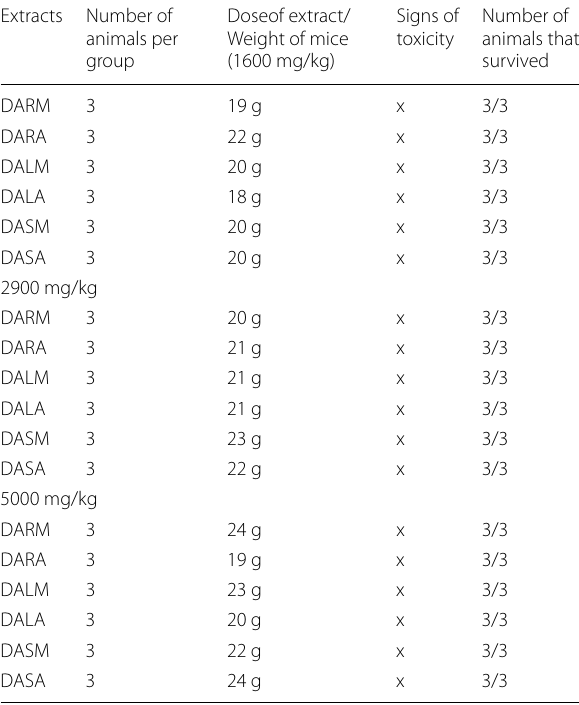
Table 3 Acute toxicity test (LD methanolic extracts of the roots, leaves, and stem of Dictyandra arborescens at high doses of 1600, 2900 and 5000 mg/kg body weight